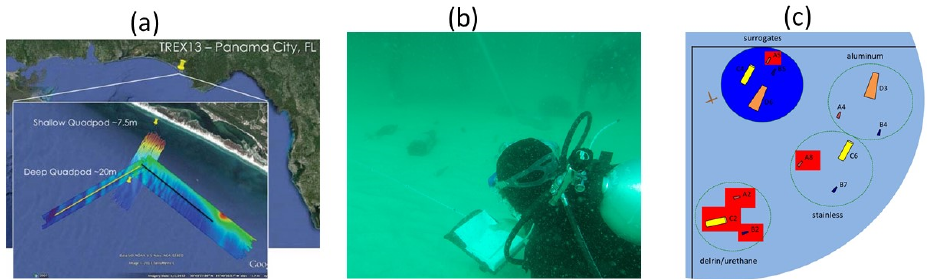
Figure 5. ( a ) Locations of deep and shallow quadpods; ( b ) photo of divers laying the object field during the shallow quadpod deployment; ( c ) layout of objects laid by divers under the shallow quadpod (from